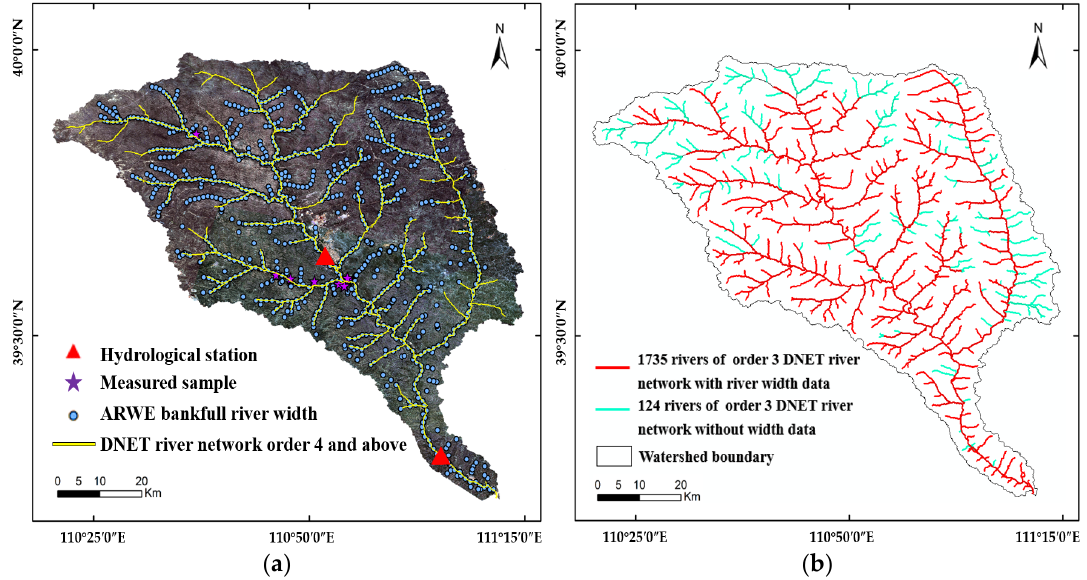
Figure 11. The river widths dataset extracted by ARWE method. ( a ) ARWE river widths data